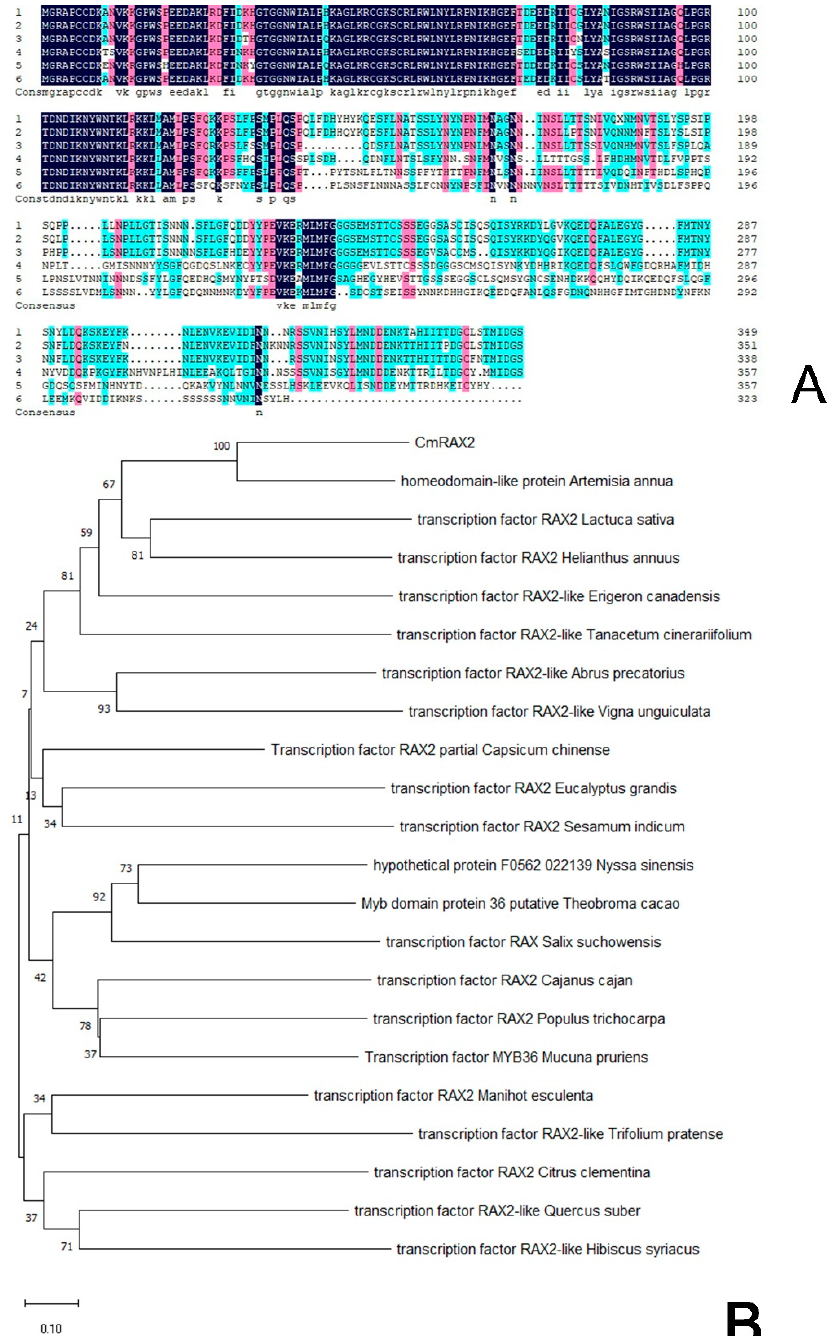
Figure 2. ( A ) Sequence alignment. ( B ) Phylogenetic tree.